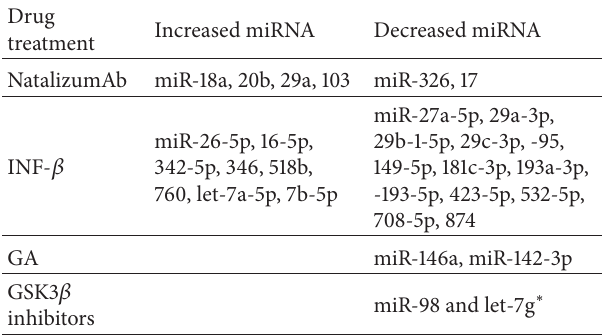
Table 1: MiRNA biomarkers of therapeutic response in multiple sclerosis